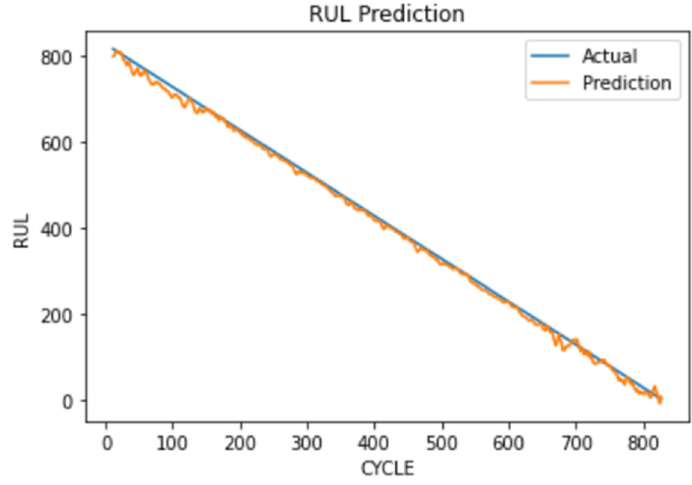
Figure 25. RUL actual vs. predicted value.